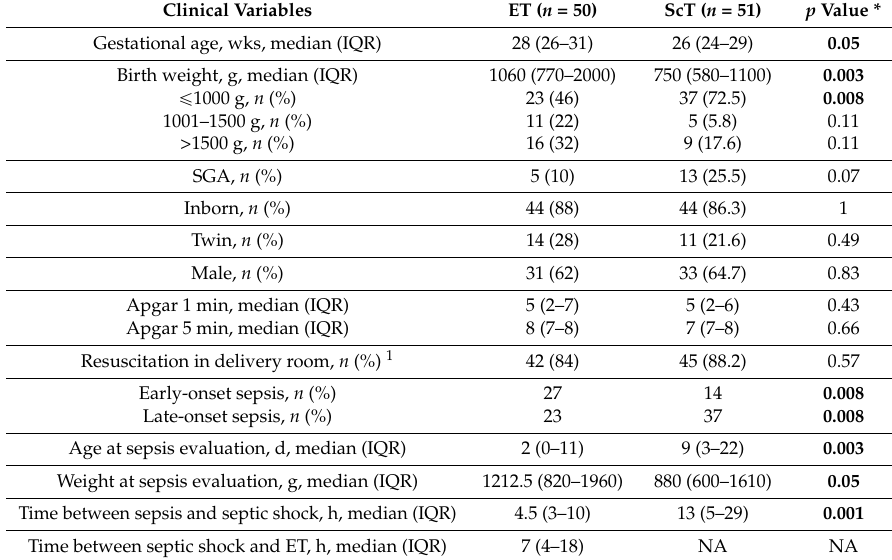
Table 1. Characteristics of the study population.